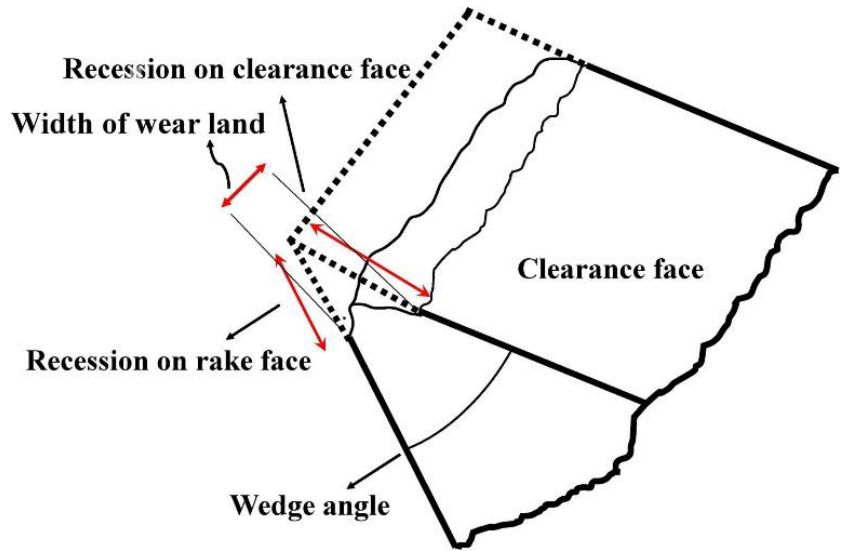
Figure 5. Image of the bull-edger system used in this study. Upon completing the test, tips from each saw were randomly selected and extracted to characterize their wear in scanning electron microscopy. The primary cutting edge, rake and clearance faces of each tip were analyzed. The second phase of the test included using saws 2, 4, and 6 for a sawing period of 480 min. Upon completion, the wear of the tips was characterized using a Reichert Jung 580 optical microscope. The images acquired were analyzed using the Image J 1.53e image analysis software. The analysis included determining the wear of the tips according to the parameters shown in Figure 6 [25]. The wear indexes were the change in recession on the rake and clearance faces and width of the wear land.